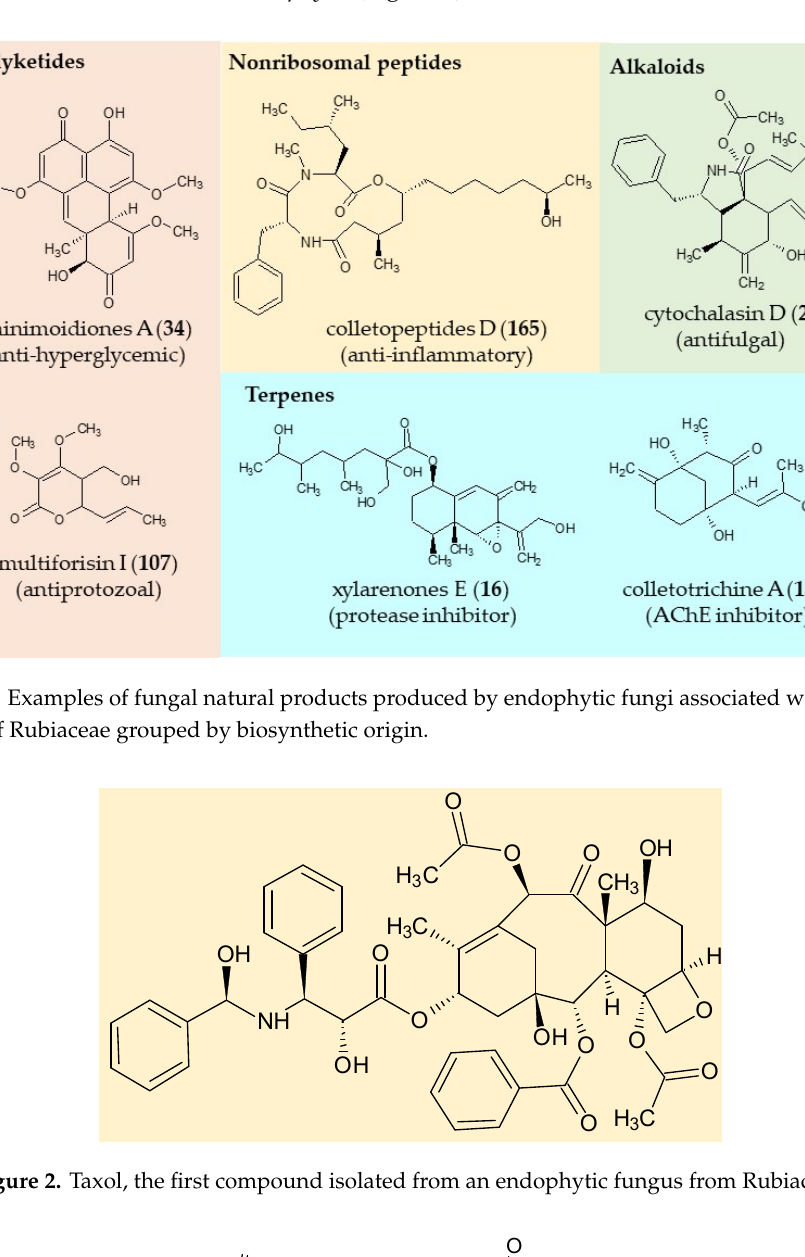
Figure 2. Taxol, the first compound isolated from an endophytic fungus from Rubiaceae.